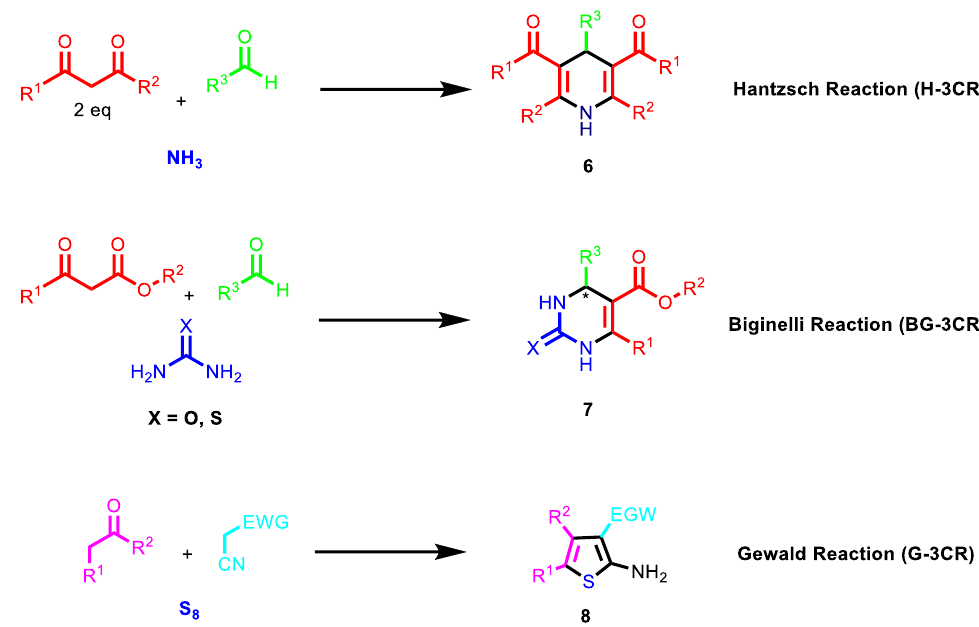
Figure 3. Non-isocyanide-based multicomponent reactions.